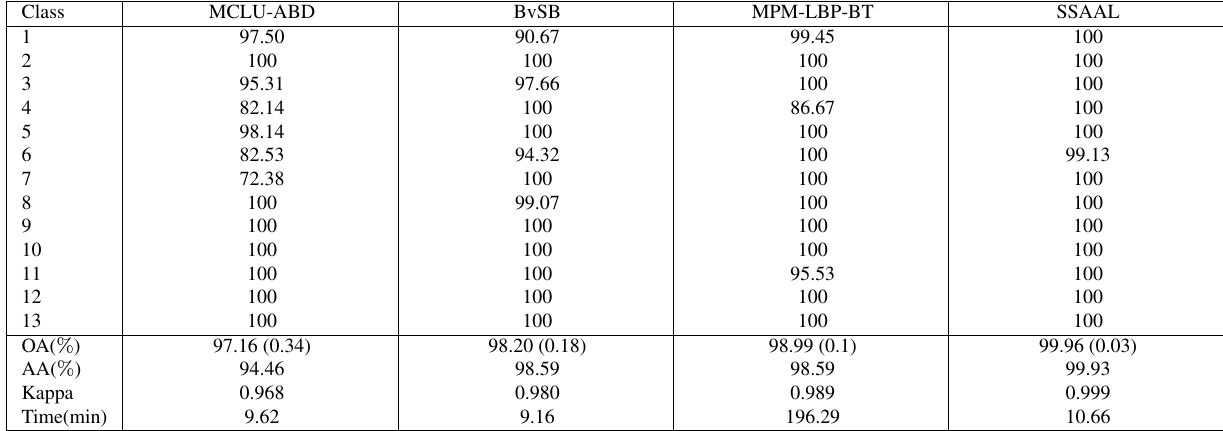
Table 7. Classification accuracies and computation time obtained by different AL techniques on KSC